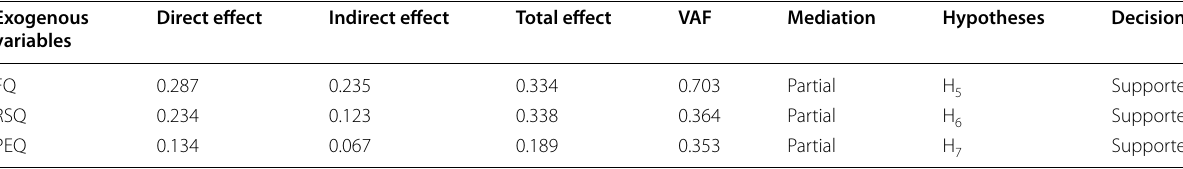
Table 7 Mediation analysis of customer satisfaction Exogenous